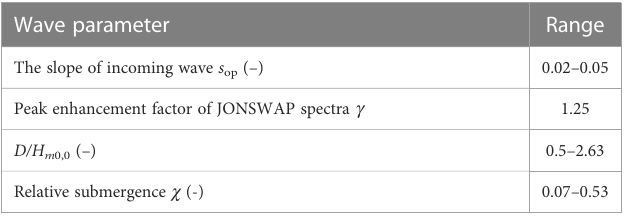
TABLE 4 Application range of the empirical formulae. Wave parameter Range